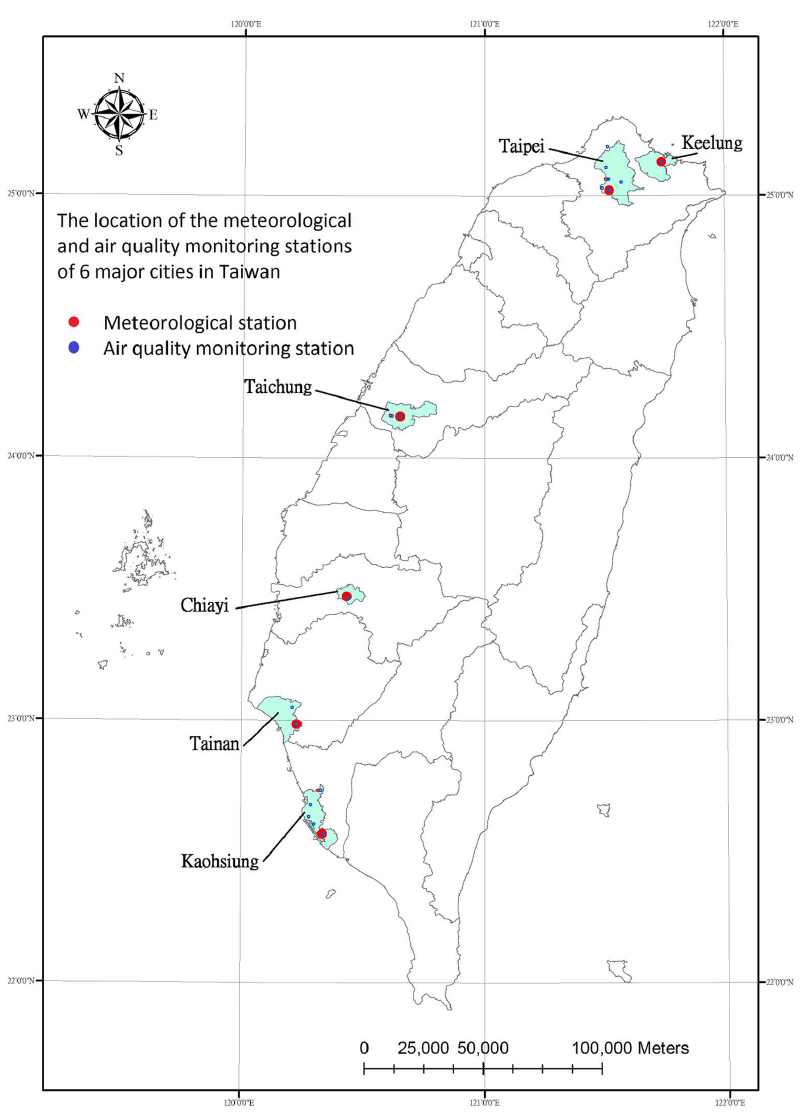
Figure 1. The locations of meteorological and air pollution monitoring stations in 6 major cities in